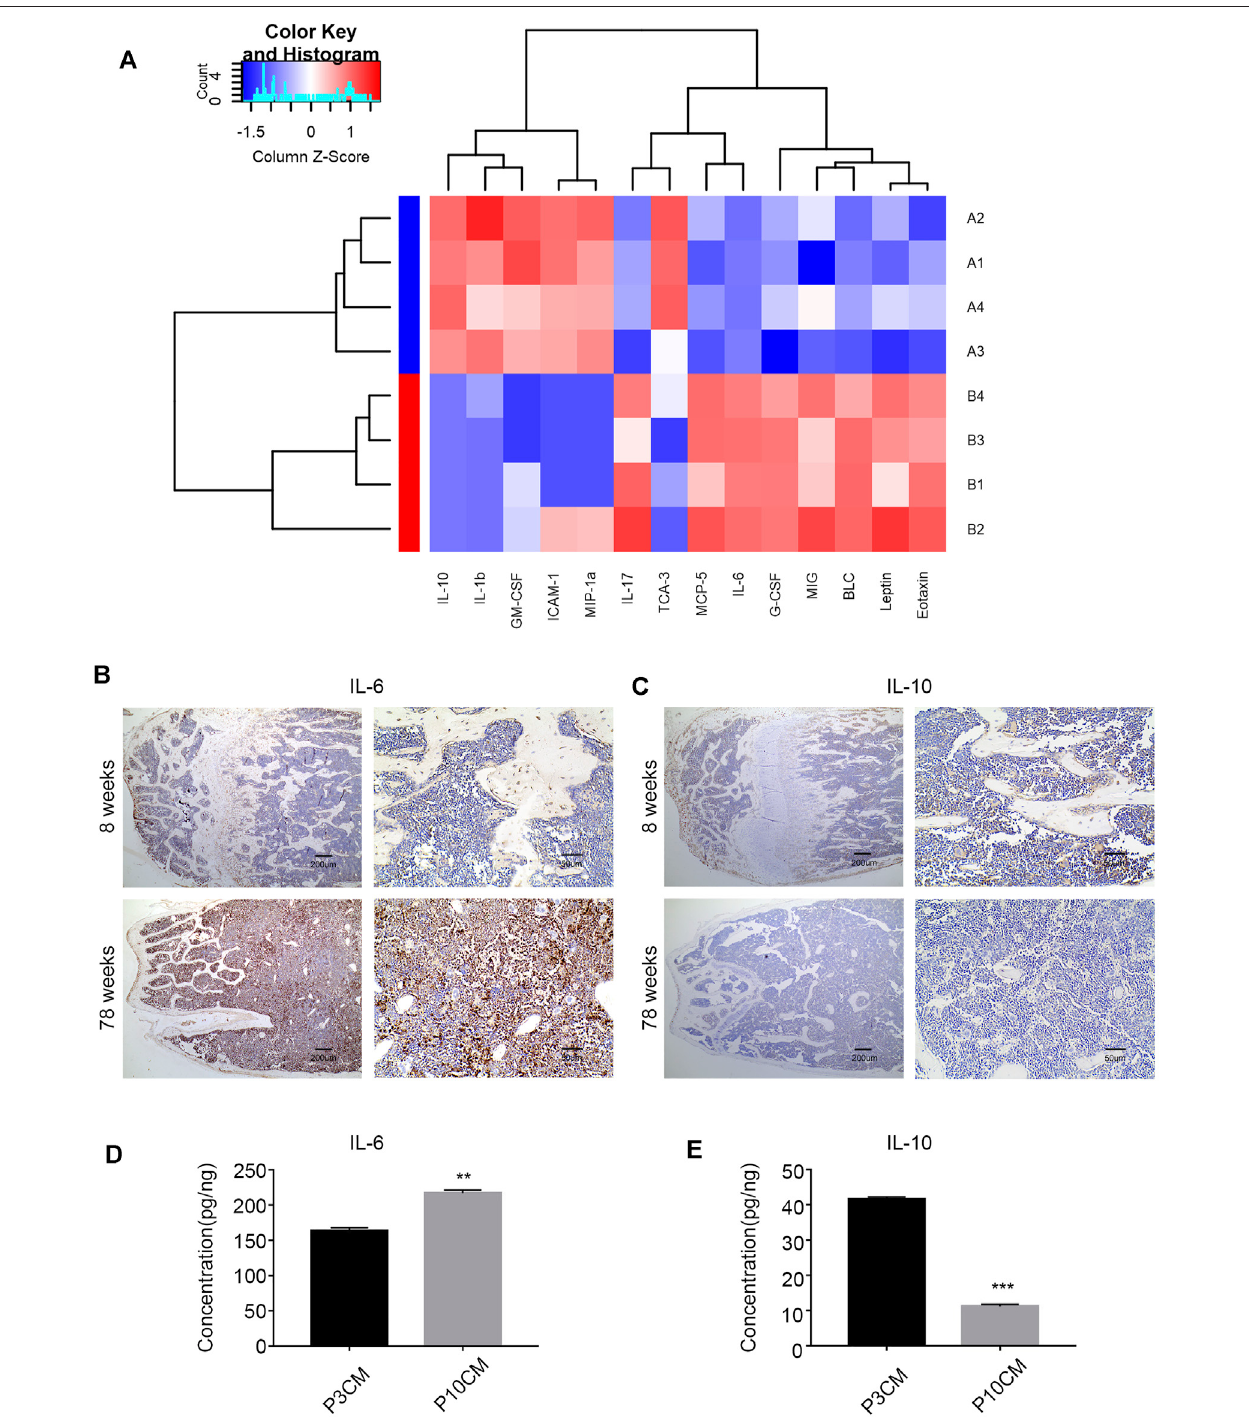
FIGURE 4 | Increased in fl ammation in the microenvironment with age. (A) Heatmap analysis of in fl ammatory factors in the serum of young mice (8 weeks old) and old mice (78 weeks old). (Group A: young group, Group B: aged group, n = 4). (B) Immunohistochemical analysis of the IL-6 expression in the bone marrow cavities of mice in different age groups. (C) Immunohistochemical analysis of the IL-10 expression in the bone marrow cavities of mice in different age groups. (D) ELISA was used toverifythelevelofIL-6inthecellsupernatantoftheyounggroup(P3CM)andsenescentgroup(P10CM)( n =3,** p < 0.01). (E) ELISAwasusedtoverifythelevelof IL-10 in the cell supernatant of the young group (P3 CM) and senescent group (P10 CM) ( n = 4 and *** p < 0.001).